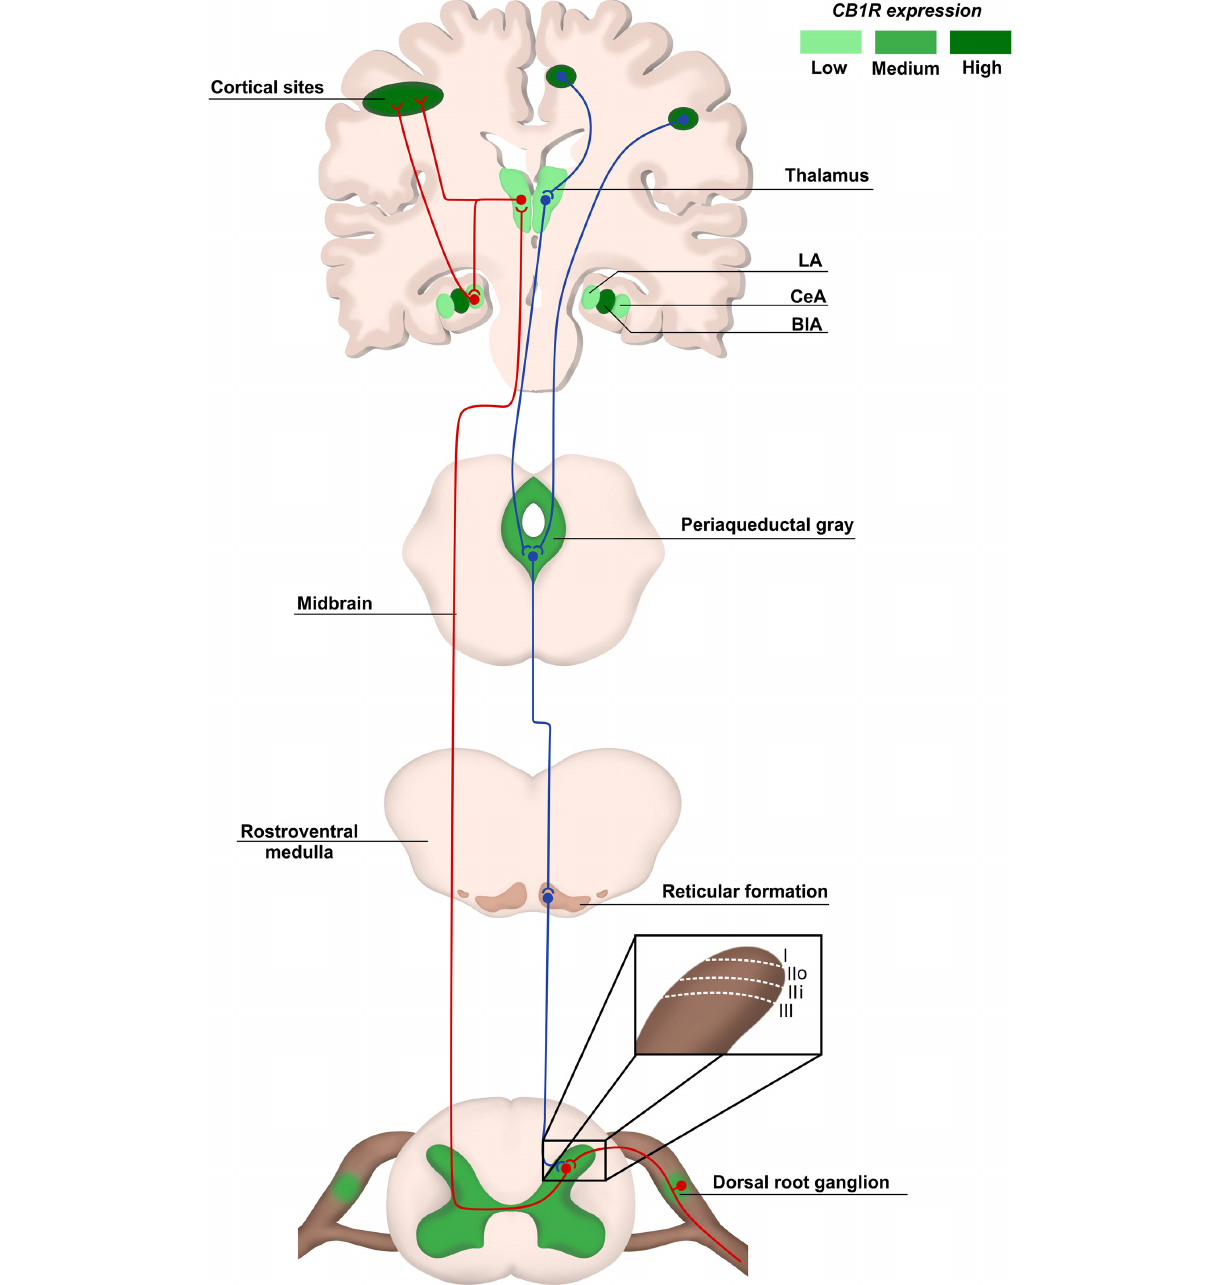
of thermal hyperalgesia and blockage of inhibition of evoked excitatory postsynaptic currents (eEPSC) in laminae II neurons in mice after administration of CB1R antagonists (Richardson et